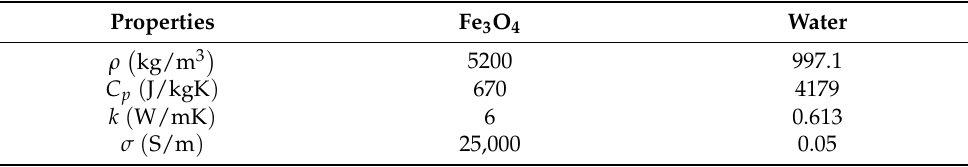
Table 1. Thermophysical properties of Fe 3 O 4 nanoparticle and water.